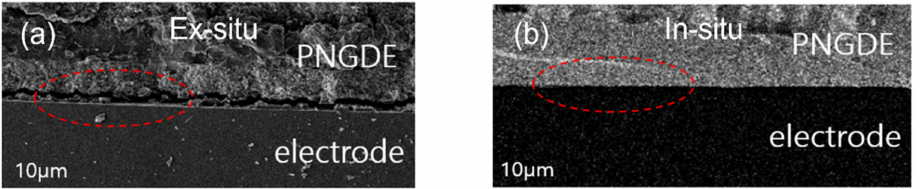
Figure 3. Cross-sectional FE-SEM images of interface via ex situ ( a ) and in situ ( b ) between PNGDE 1.5 and LiFePO 4 (marked red dash line displayed corresponding interphase